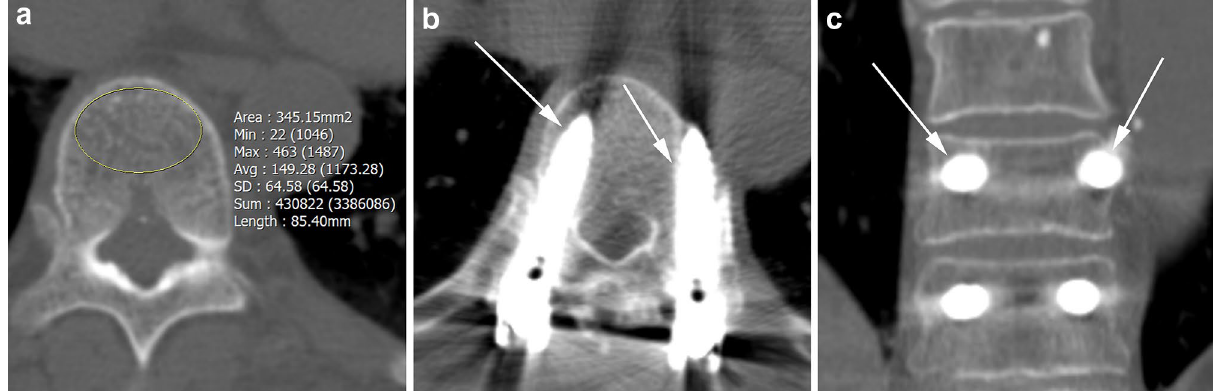
Figure 5. A 77-year-old woman who underwent spinal fusion surgery from T10 to S1. In the axial plane of the preoperative CT scan ( a ), the Hounsfield unit value of the upper instrumented vertebral body (T10) was 149.28, which was higher than the cutoff value. Postoperative CT performed 2 years and 7 months after surgery did not show screw loosening in the axial ( b ) or coronal ( c ) planes (arrows). min minimum, max maximum, avg average, SD standard deviation.